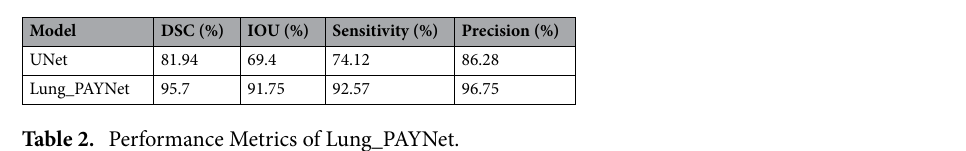
Table 2. Performance Metrics of